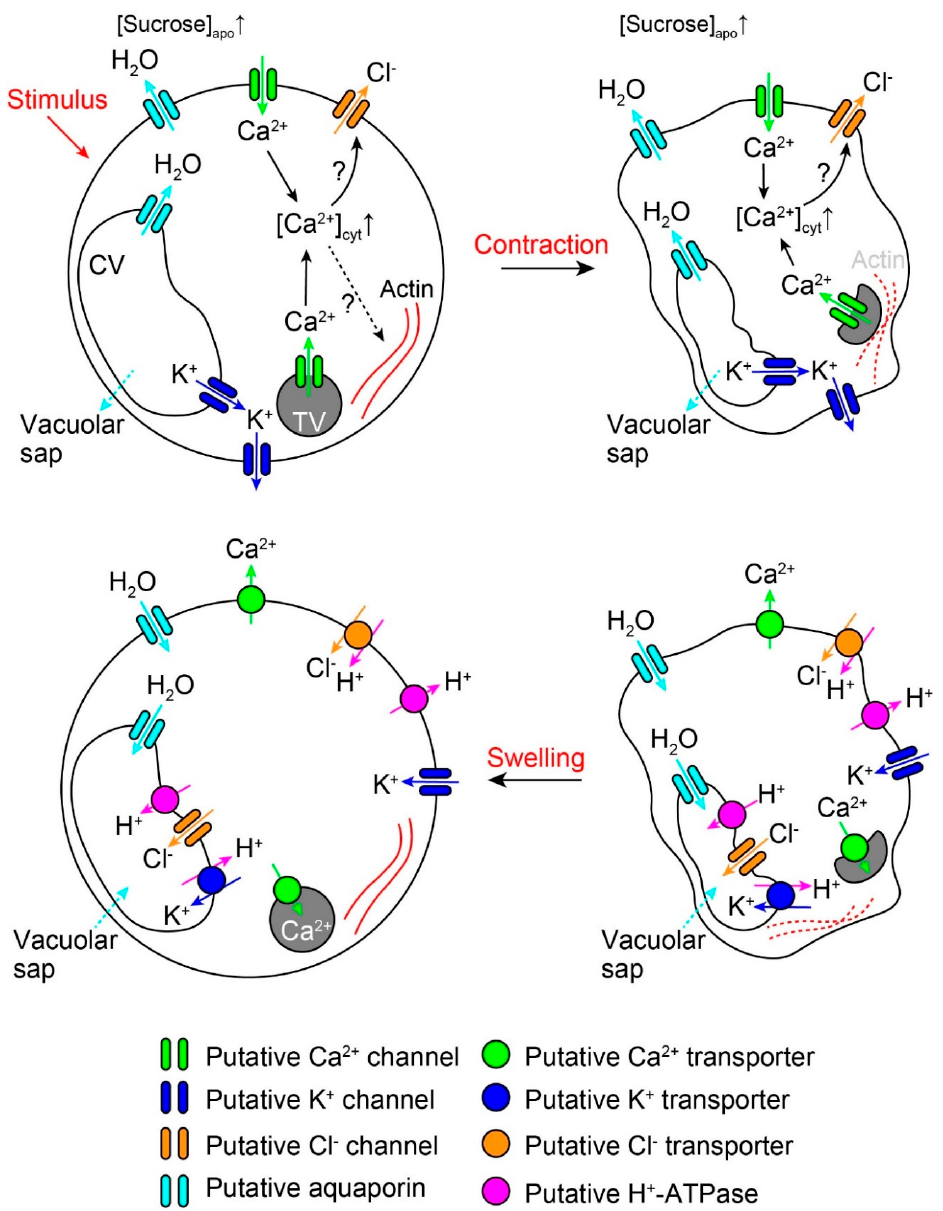
Figure 2. The turgor loss model for rapid movement in M. pudica . Extensor motor cells release electrolytes into the apoplastic region in response to a mechanical stimulus. Subsequently, water is osmotically released into the extracellular space. The electrolytes are transferred through voltage-dependent K + and Cl - channels, which are activated by the action potential. Ca 2+ influx via the plasma membrane and Ca 2+ efflux from the tannin vacuole result in an increase in [Ca 2+ ] cyt, which activate a Ca 2+ -dependent Cl - -channel to depolarize the plasma membrane. The increase in [Ca 2+ ] cyt might also facilitate rapid movements via actin filament depolymerization. Alternatively, the central vacuole may release its sap through an unknown mechanism in response to a mechanical stimulus (dashed blue arrows, top panels). In the recovery phase, the effused substances and water are taken back into the cell to restore the turgor (bottom panels). H + -ATPase provides the energy required for the active uptake of effused substances. K + is transferred into the cells via an inwardly rectified K + channel. Ca 2+ migrates to tannin vacuoles and the apoplastic region via a Ca 2+ pump. CV, central vacuole; TV, tannin vacuole.